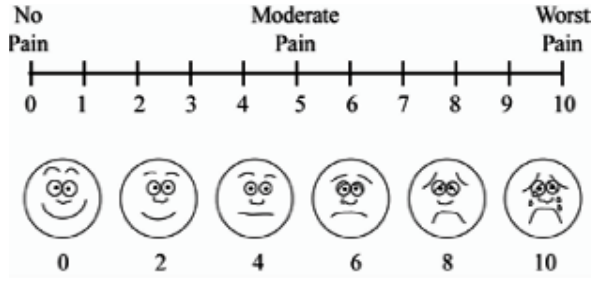
Figure-II: Visual analog